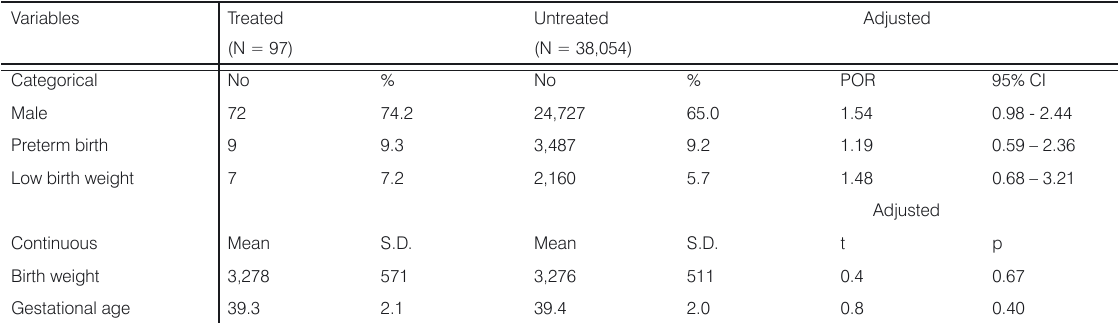
Table 4. Characteristics of newborn infants born to mothers with or without HCG treatment.